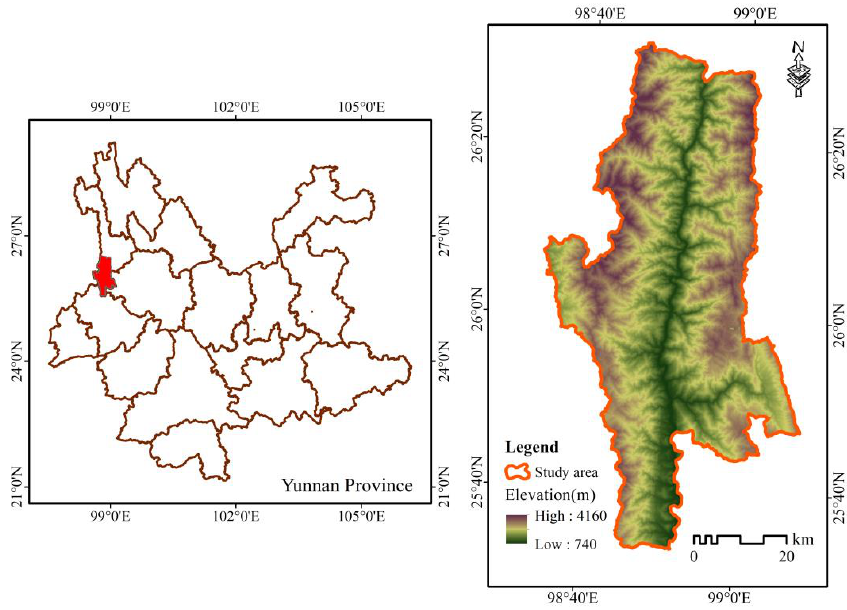
Figure 2. Position of the study area.